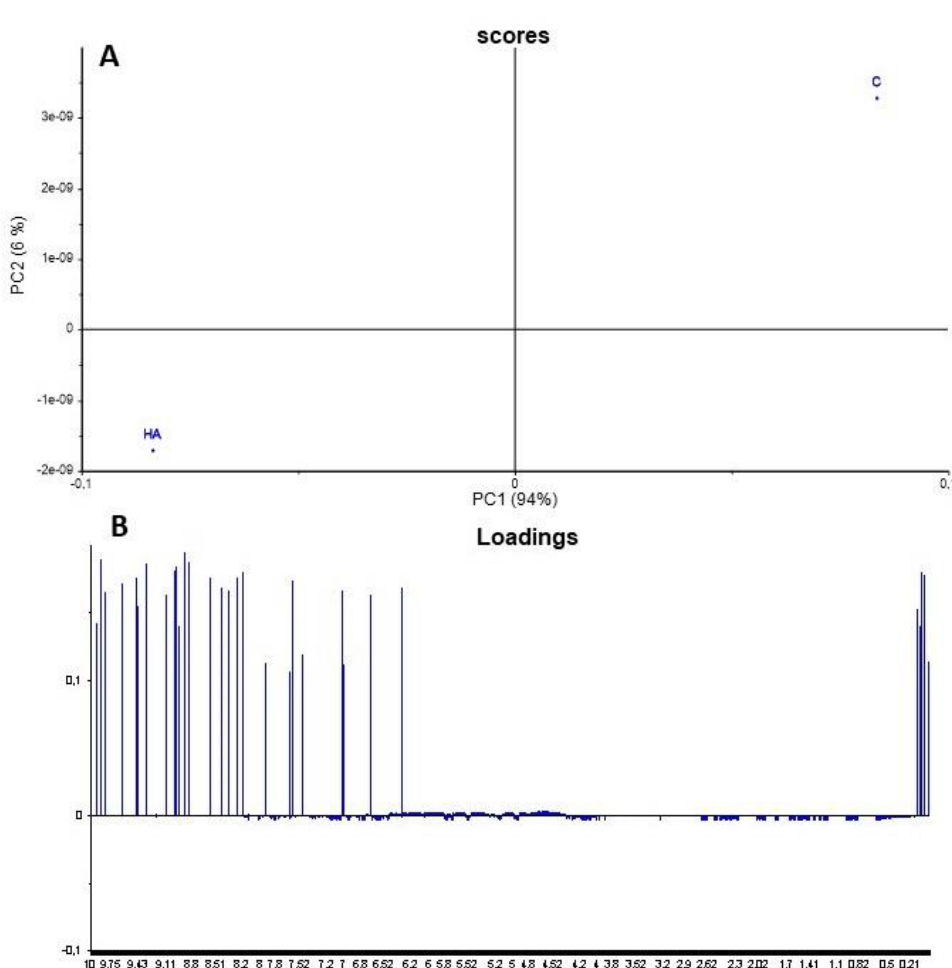
Figure 3. PCA scores ( A ) and loadings ( B ) show a good separation between leaf tissues of rice seedlings treated with humic acids (HA) concerning control plants (C).